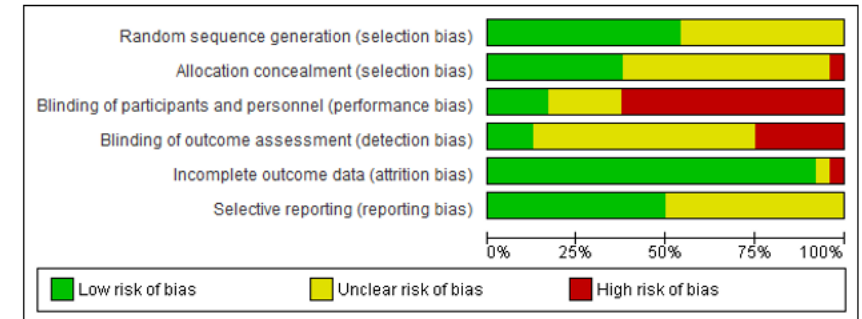
Figure 3. Risk of bias graph.